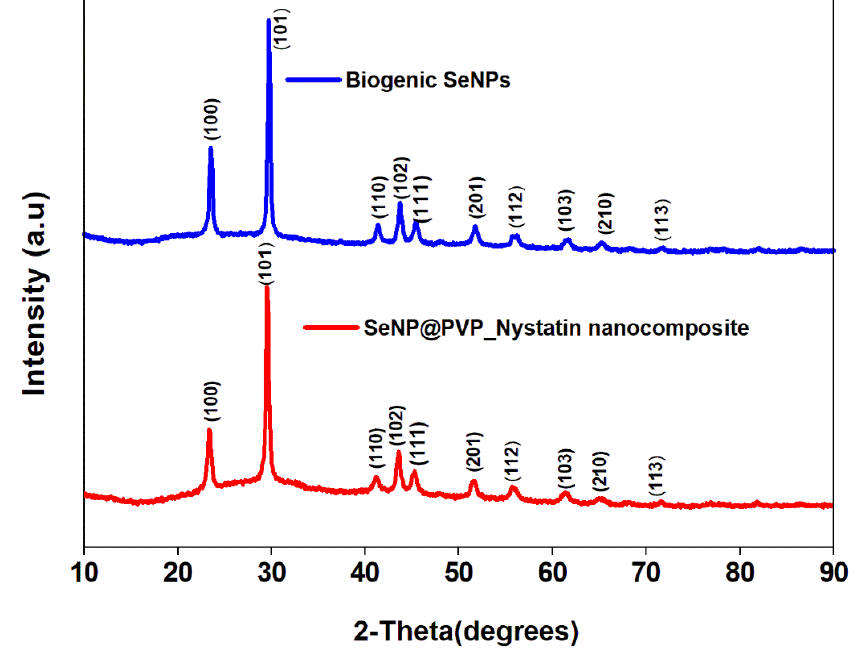
Figure 2. XRD analysis of biogenic SeNPs and SeNP@PVP_Nystatin nanocomposites, showing characteristic 2θ values indexed at the (100), (101), (110), (102), (111), (201), (112), (103), (210), and (113) planes.